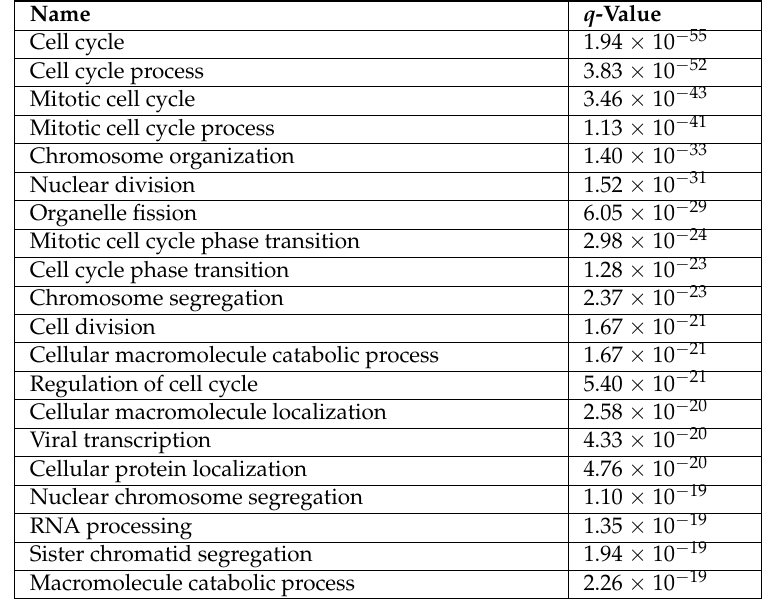
Table 3. ToppFun GO functional enrichment analysis—Biological Process (BP). The top 20 significant BP terms are shown below.